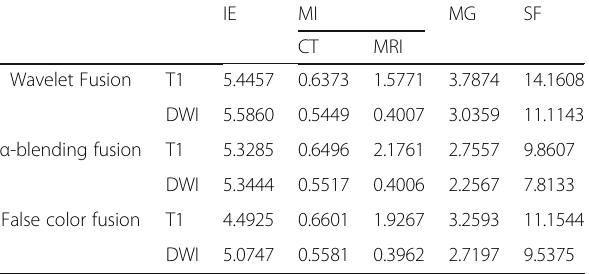
Table 2 The objective evaluation parameters of fusion results IE